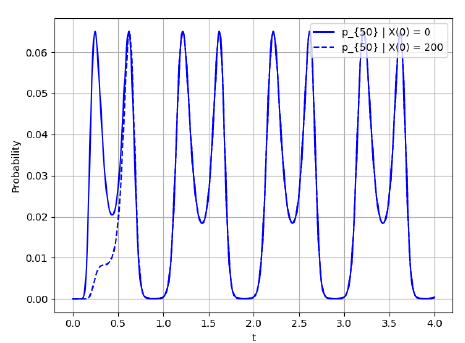
Figure 9. Probability p 50 ( t ) , p 51 ( t ) for t ∈ [ 0,4 ] ; this figure shows the rate of convergence.